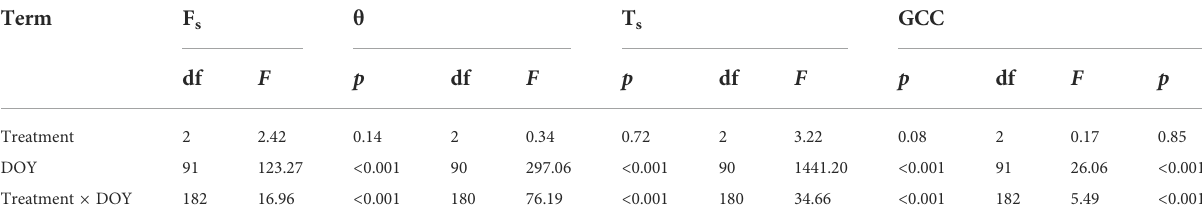
TABLE1Linearmixed-effectsmodelresults fordailymeansoilCO 2 ef fl ux(F s ),soil moisture( θ ),soiltemperature(T s ),andgreen chromaticcoordinate (GCC) normalized anomalies.